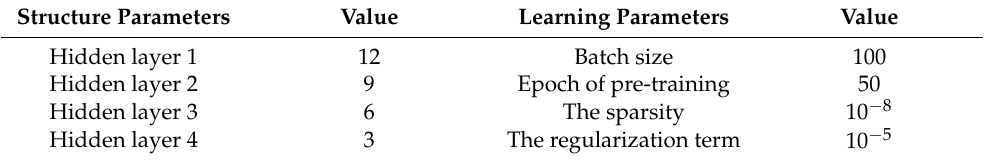
Table 4. Summary of SSDAE